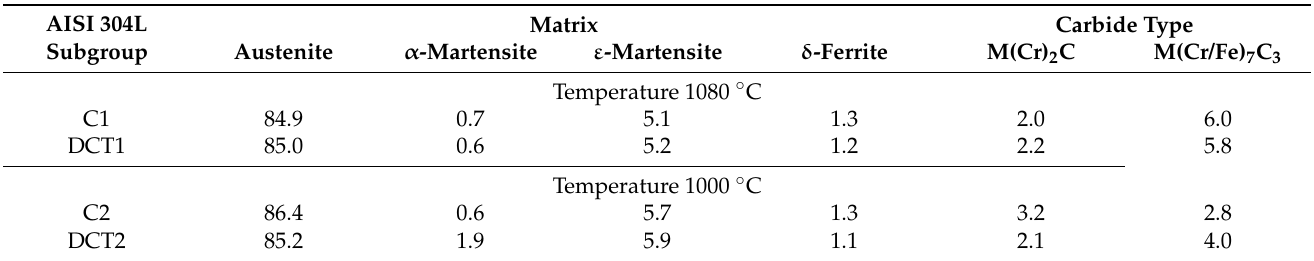
Table 2. Phase composition (in vol.%) of each subgroup (solution annealing and DCT) of austenitic stainless steel AISI